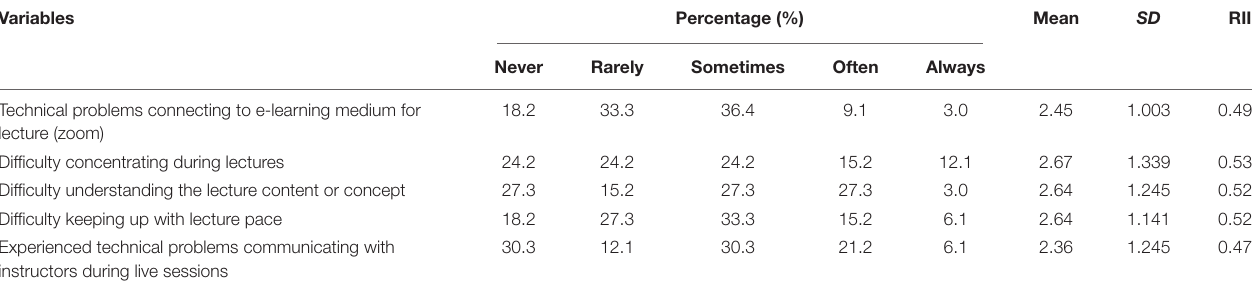
TABLE 2 | Students’ experience with online lecture delivery.